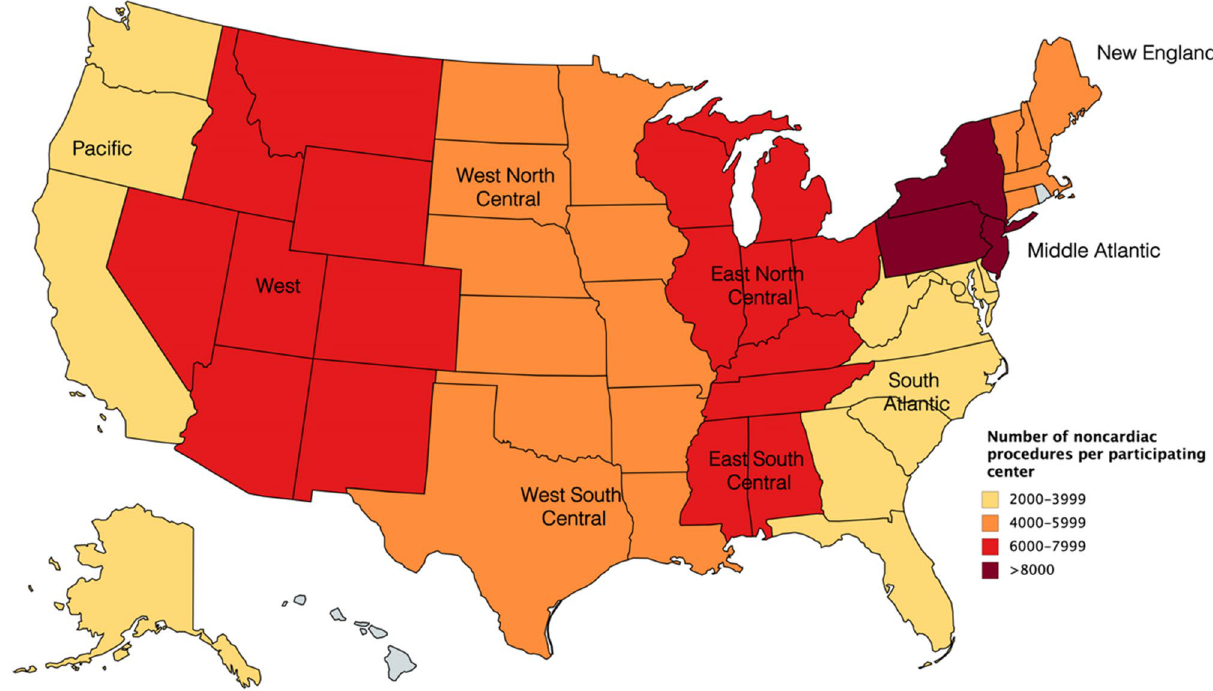
Figure 1. Number of noncardiac procedures per participating center in the United States. The map was created using mapchart.net (https ://mapch